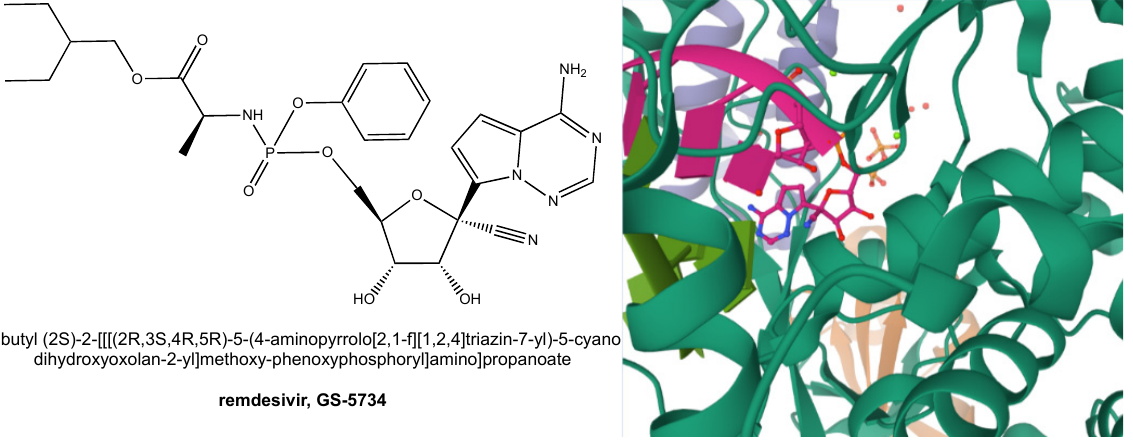
Figure 4. Structural representation of remdesivir (with use and IUPAC names, left ) and view of its triphosphate form bound to SARS-CoV-2 RdRp in the active site (PDB ID: 7BV2 [132], image obtained using Mol* [133], https://www.rcsb.org/3d-view/7BV2 (accessed on 10 December 2020), right ).